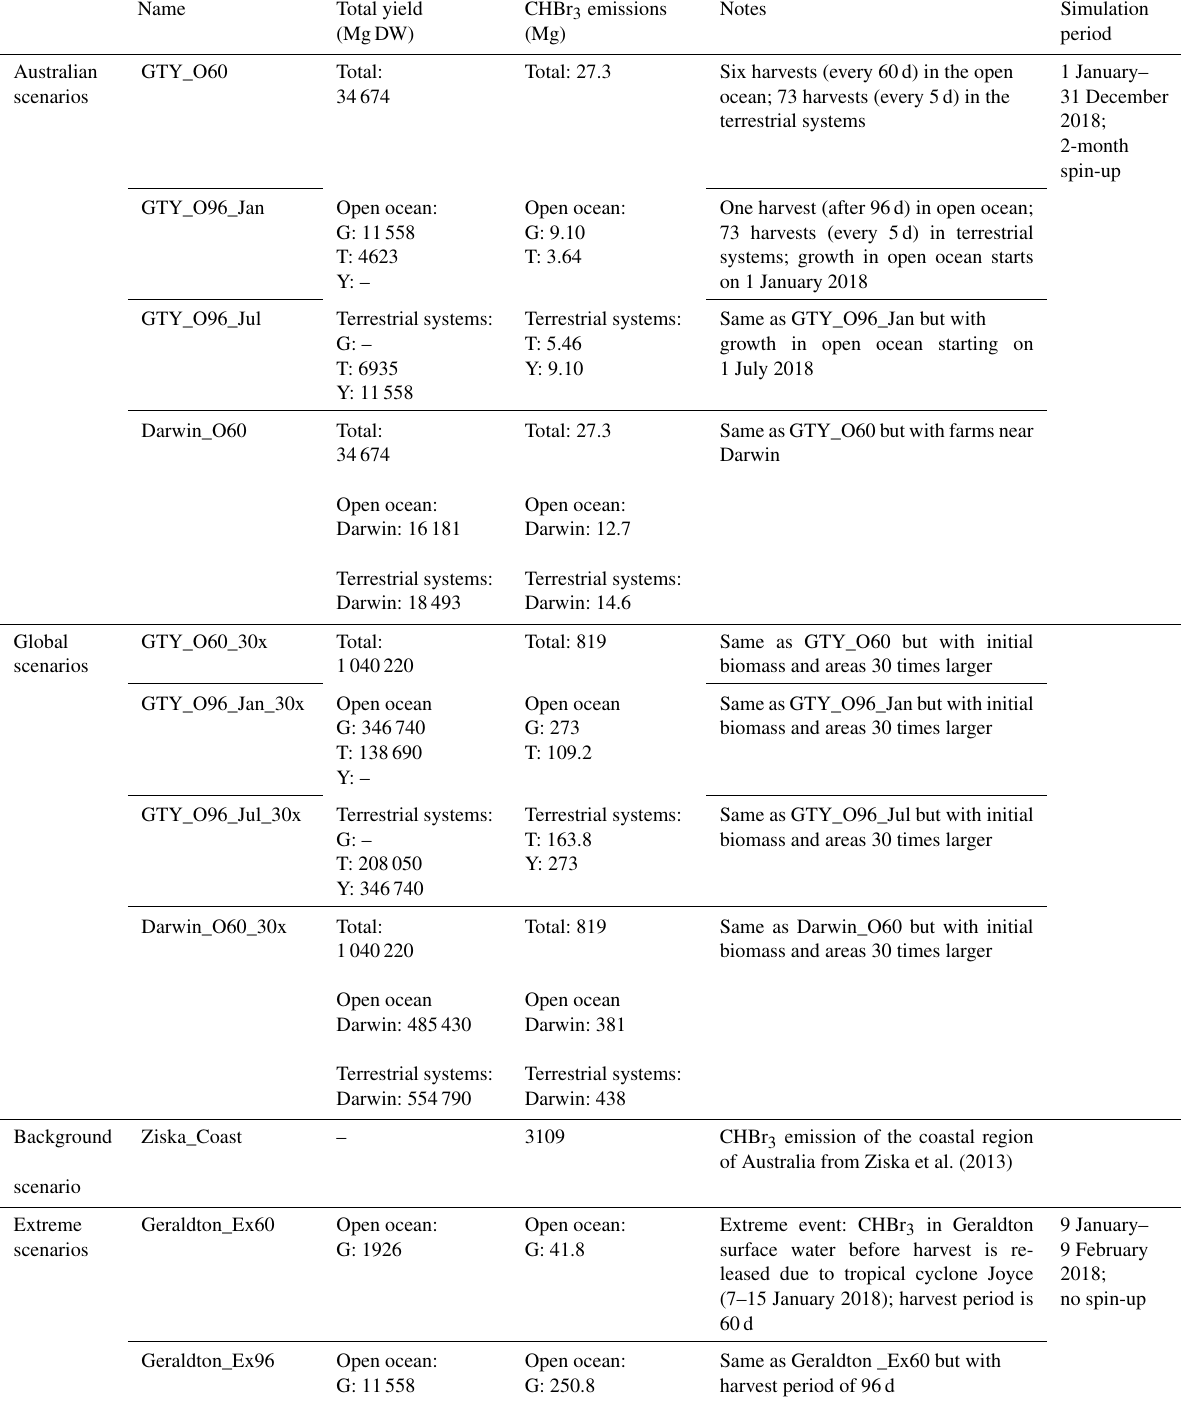
Table 1. Detailed information on the scenarios set up for the atmospheric transport simulations with FLEXPART (Geraldton, Triabunna, and Yamba: